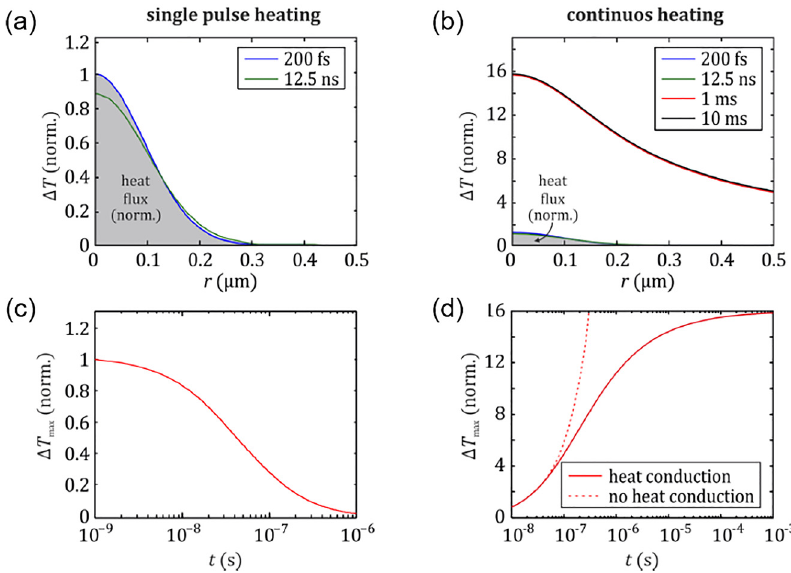
tion threshold. Increasing I , more radicals can be gener- ated, but the optical damage threshold I dt should not be exceeded. To avoid damage, the concentration of the rad- icals can be controlled via an appropriate quantity of